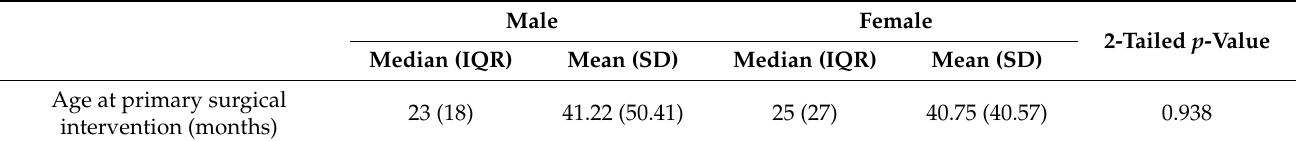
Figure 1. Summary of the patient records included in the study.